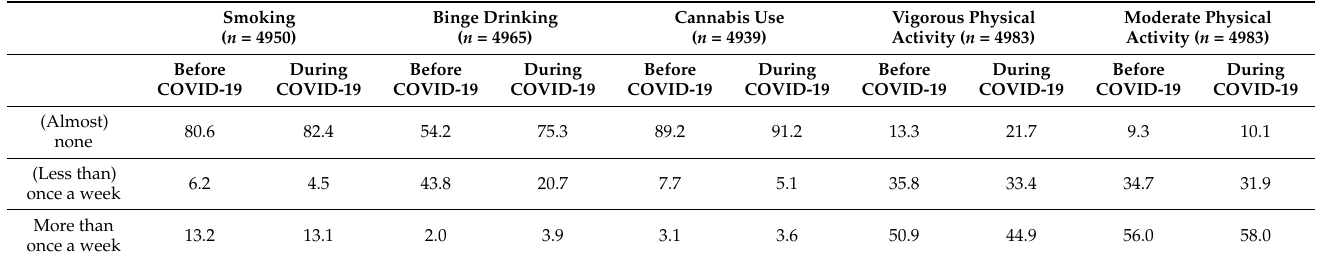
Table 2. Health risk behaviors (HRB) among German university students (in %).